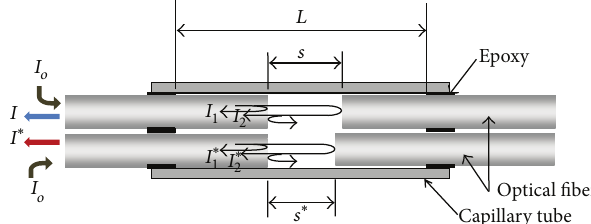
Figure1:Schematicdiagramofdual-cavityFabry-PerotInterferom- eter.